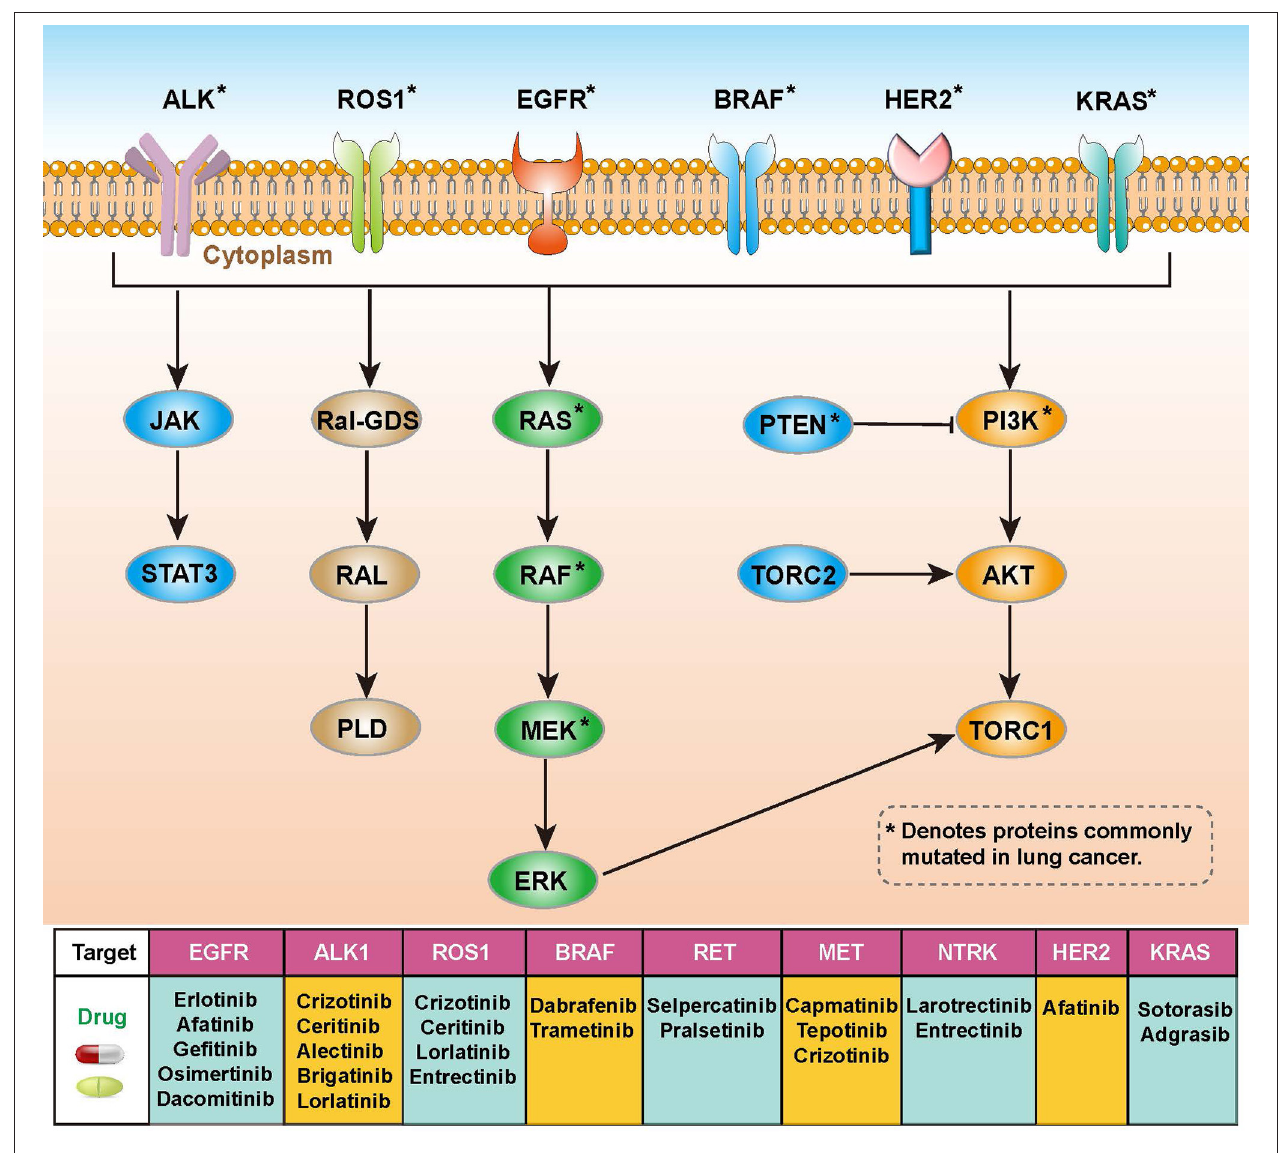
FIGURE 1 | Overview of molecular pathways, potential targets and drugs in non-small cell lung cancer